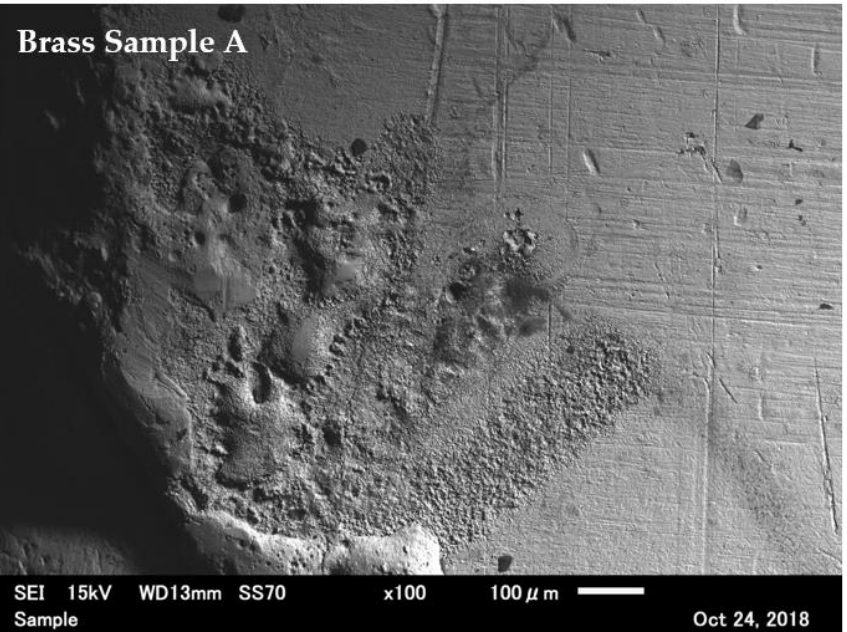
Figure 14. The same brass contact surface after it was subjected to an electrical arc of 4 A, viewed under an electron microscope at 100 × magnification. This brass sample was not treated with HCl due to zinc being reactive to the acid which may damage the